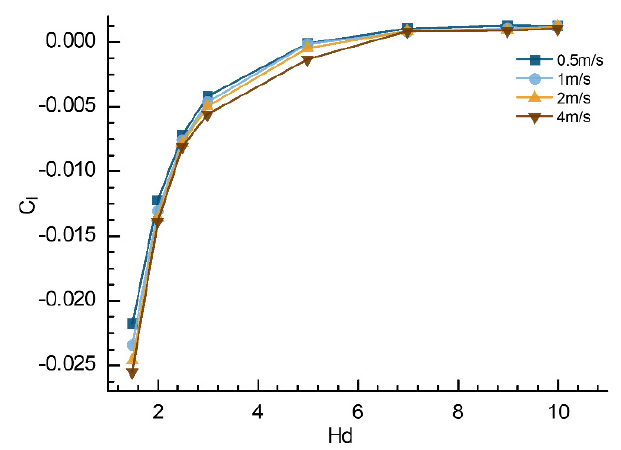
Figure 7. Bare UUV lift characteristic.